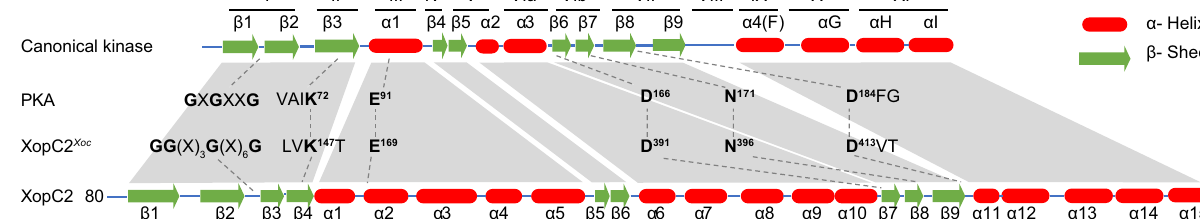
Fig. 1 XopC2 represents a family of effector kinases. a Sequence alignment of catalytic motifs in different families of protein kinases. Eight representative protein kinases with the highest scores in the output list from HHpred searches against the conserved motif (391 – 417 amino-acid residues) of XopC2 were aligned with ClustalX, and the conserved catalytic sites were highlighted in purple boxes. b Schematic diagrams of secondary structures of canonical kinases and XopC2. The top row showed the generally conserved secondary structure pro fi le of canonical kinases 38 . Twelve subdomains and conserved structural characteristics were marked based on standard kinase annotations 70 . The bottom row showed the secondary structure pro fi le of XopC2. The key conserved residues of canonical kinases and XopC2 were numbered based on the human canonical protein kinase A (PKA) and XopC2 Xoc , respectively, and were shown in the middle. c In vitro puri fi ed XopC2 was autophosphorylated, while the point mutations D391A and N396A reduced the autophosphorylation of XopC2 as revealed by in vitro kinase assays. Upper panel, His6-XopC2 phosphorylation was detected by autoradiography. Lower panel, the proteins were stained with Coomassie brilliant blue (CBB) as a loading control. The experiments were independently repeated 3 times with similar